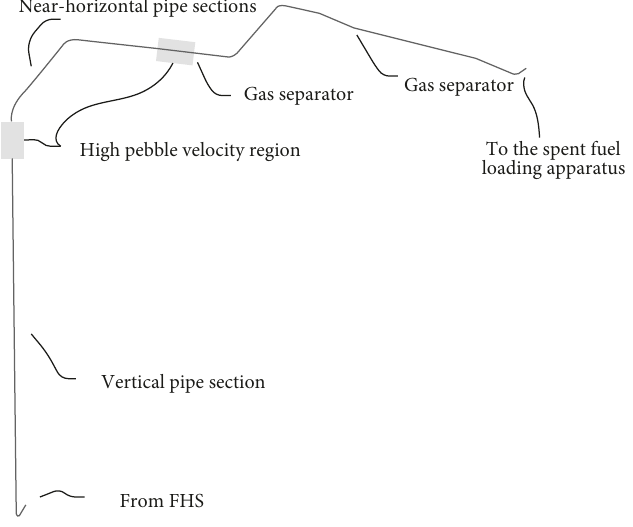
Figure 4: Schematic drawing of the pebble conveying pipeline.